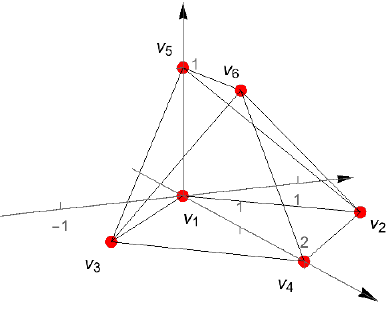
Figure 5 . Toric diagram for the link of the SPP 4-fold